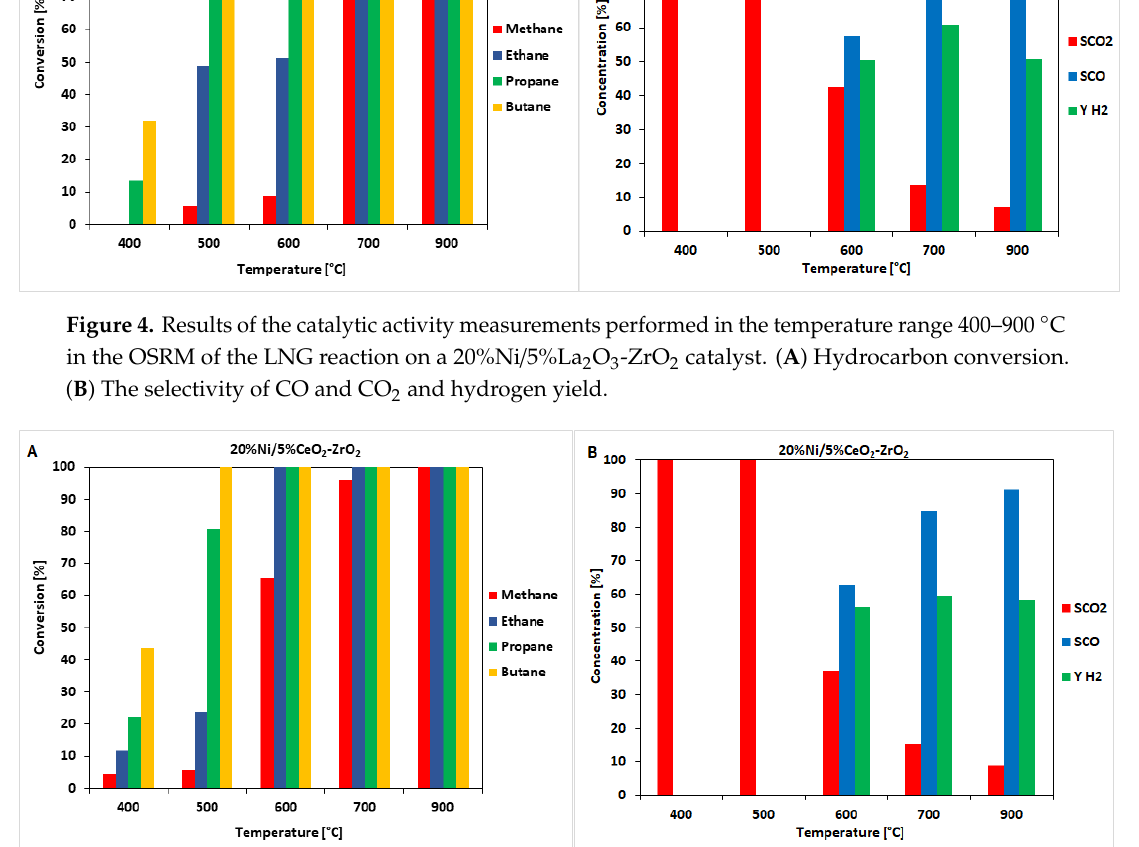
Figure 5. Results of the catalytic activity measurements performed in the temperature range 400–900 ◦ C in the OSRM of the LNG reaction on a 20%Ni / 5%CeO 2 -ZrO 2 catalyst. ( A ) Hydrocarbon conversion. ( B ) The selectivity of CO and CO 2 and hydrogen